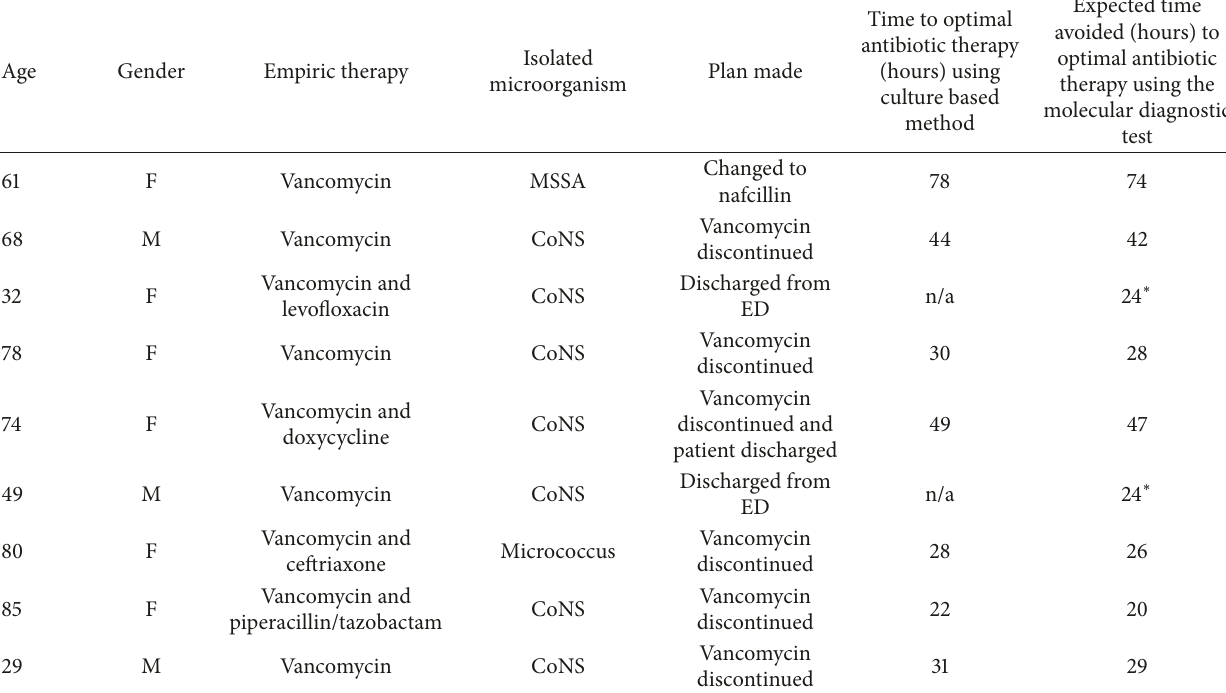
Table 1: Patients who met inclusion criteria for rapid diagnostic testing a .